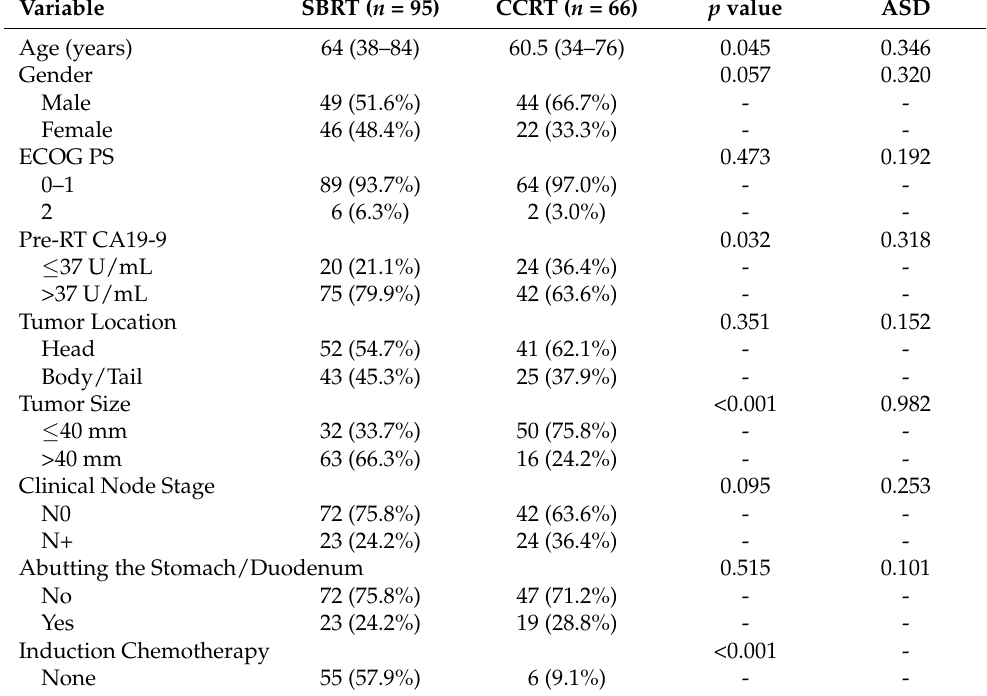
Table 1. Characteristics of the unmatched cohort at the time of